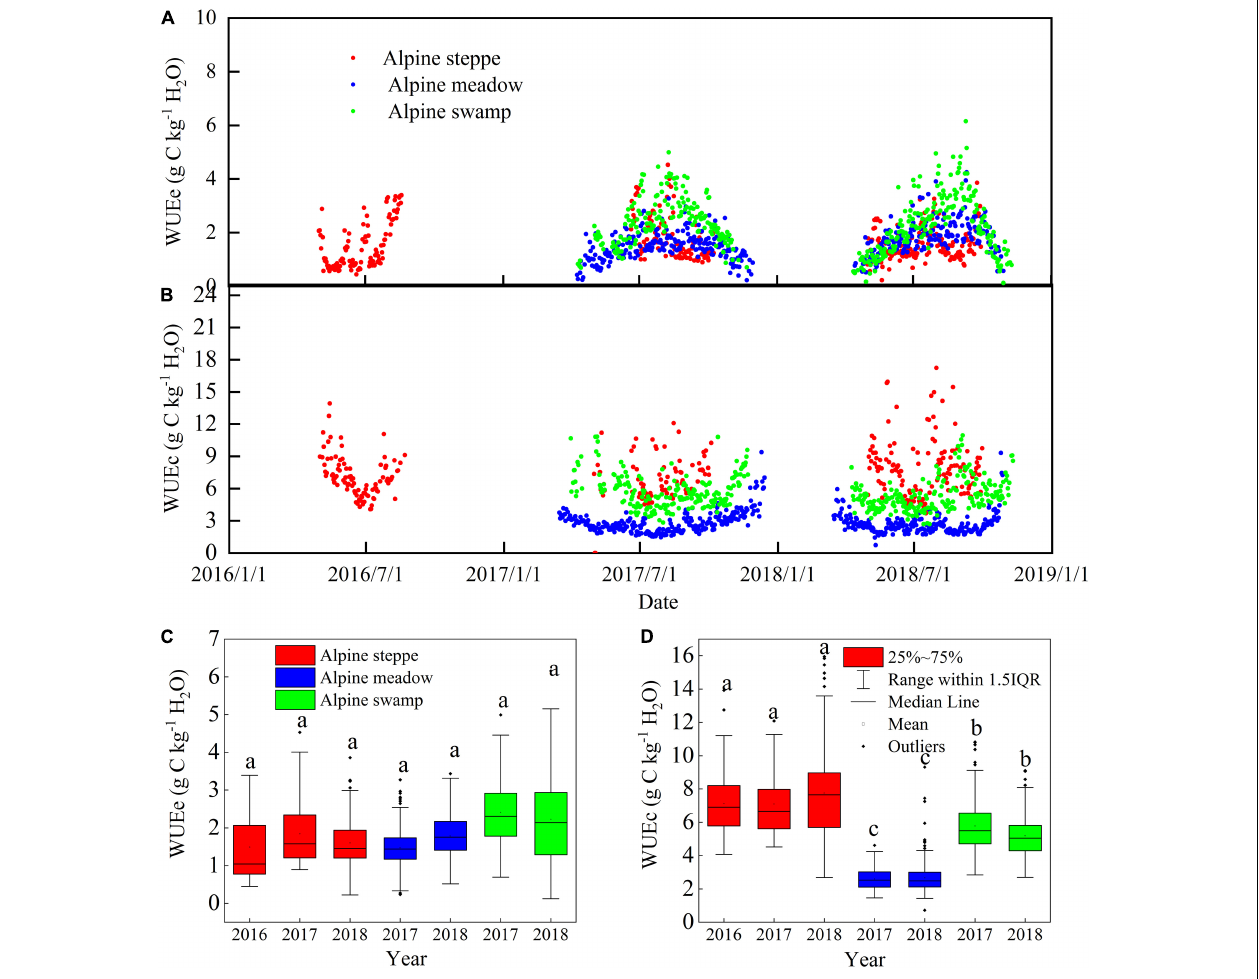
FIGURE 5 | Comparison of seasonal dynamics of (A) WUEc and (B) WUEe, and the range of daily (C) WUEc and (D) WUEe in alpine steppe, alpine meadow, and alpine swamp during the study period. Different small letters indicate significant differences ( P < 0.05).